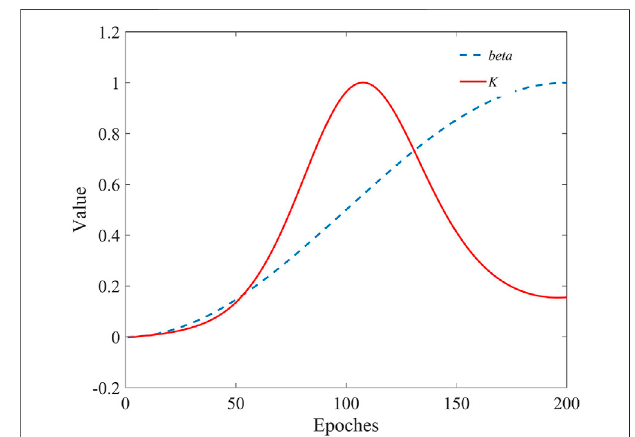
FIGURE 2 | Variation of step size factors with the number of